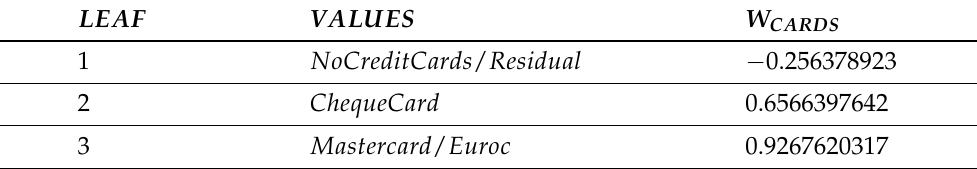
Figure 6. CART trees adjusted to variables CREDIT _ CARDS and CASH in CS _ ACCEPTS dataset (depth = 1). Table 5. Values obtained for W CARDS from the tree depicted in Figure 6 (left).